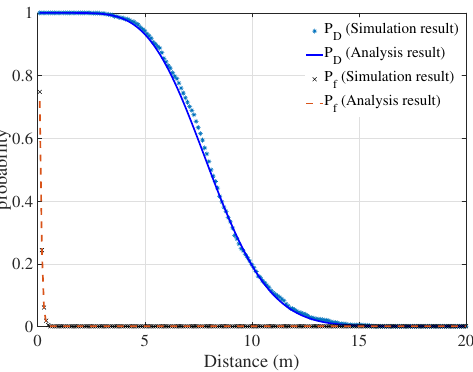
Figure 6. False alarm/detection probabilities of the system under Nakagami-2 channel